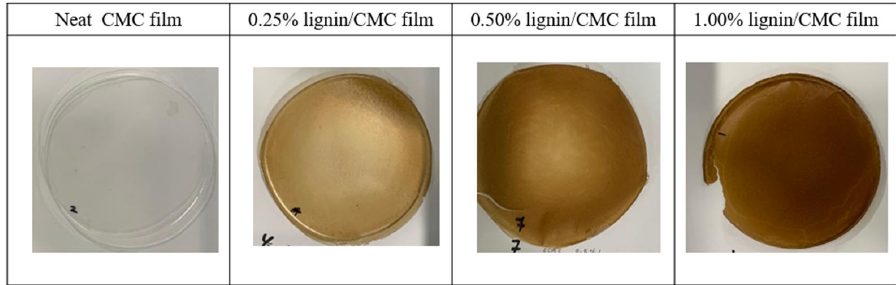
Figure 2. The appearance and colour of the neat CMC film and lignin/CMC films. In addition to the visual observation, the results of the UV/vis measurement are pre ‐ sented in Figure 3. Neat CMC film absorbed some UVC (200–279 nm), but allowed a ma ‐ jority of UVB (280–314 nm) and UVA (315–399 nm) to pass through. On the contrary, lig ‐ nin/CMC was shown to absorb UVA and UVB, attributed to the UV ‐ shielding property exhibited by lignin and substantiated by the enhanced absorption (or reduced transmit ‐ tance) of UV wavelengths with the increased amount of lignin present in the films. The different chromophores that contributed to the enhanced absorbance in the 200–400 nm ‐ UV range were described previously by Sadeghifar et al. [35]. In fact, UV ‐ vis was estab ‐ lished as an excellent system and process analytical tool to quickly quantify lignin by em ‐ ploying the wavelengths at 205 nm and 280 nm [36]. While the dark color of lignin might limit its application as a natural ingredient in certain areas, for instance, in dye ‐ stuff dis ‐ persants, sunscreens, and also in packaging, where transparent materials are generally preferred; for products that are easily degraded from exposure to light, the UV ‐ blocking lignin/CMC films could be an advantage to protect the products and preserve their qual ‐ ity. An example of the potential use of lignin/CMC film is the packaging of laver or fish oil, and many other food products rich in triglycerides, to shield the effect of sunlight, which has been shown to accelerate lipid oxidation and the degradation of antioxidants [37,38]. Figure 3. UV/vis spectra of lignin/CMC films, recorded from 210–800 nm. Numerous research efforts are underway, and methods have been developed to re ‐ duce the color of lignin, including one ‐ step UV irradiation of lignin at 365 nm in tetrahy ‐ drofuran (THF) solvent [39]. Modifications to the extraction and fractionation process of lignin with methanol/water to get a low molecular weight fraction, which has a lighter color compared to its high molecular weight counterpart [40,41], and the bleaching aspect of lignin/CMC film, will be explored in future study.